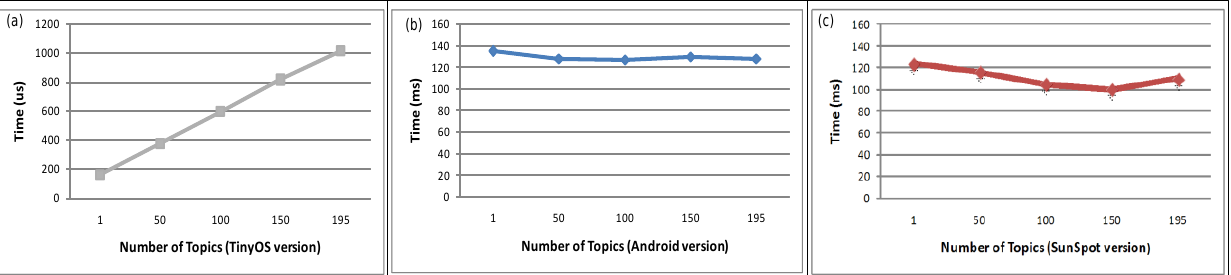
Figure 11. Reception of monitored data when many topics